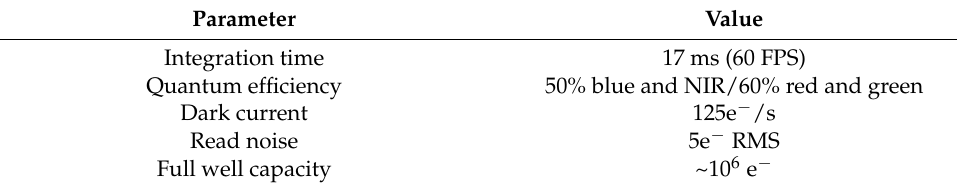
Table 8. SNR analysis parameters.